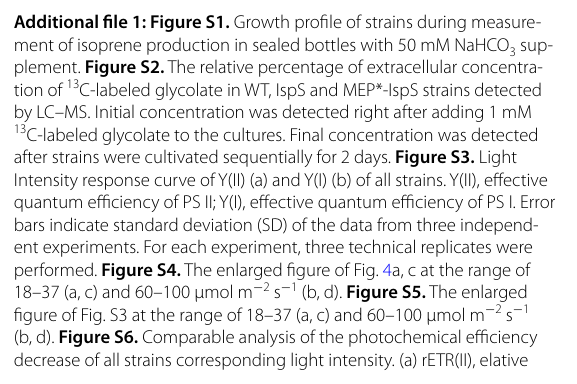
plement. Figure S2. The relative percentage of extracellular concentra- tion of 13 C-labeled glycolate in WT, IspS and MEP*-IspS strains detected by LC–MS. Initial concentration was detected right after adding 1 mM 13 C-labeled glycolate to the cultures. Final concentration was detected after strains were cultivated sequentially for 2 days. Figure S3. Light Intensity response curve of Y(II) (a) and Y(I) (b) of all strains. Y(II), effective quantum efficiency of PS II; Y(I), effective quantum efficiency of PS I. Error bars indicate standard deviation (SD) of the data from three independ- ent experiments. For each experiment, three technical replicates were performed. Figure S4. The enlarged figure of Fig. 4a, c at the range of (b, d). Figure S6. Comparable analysis of the photochemical efficiency decrease of all strains corresponding light intensity. (a) rETR(II), elative